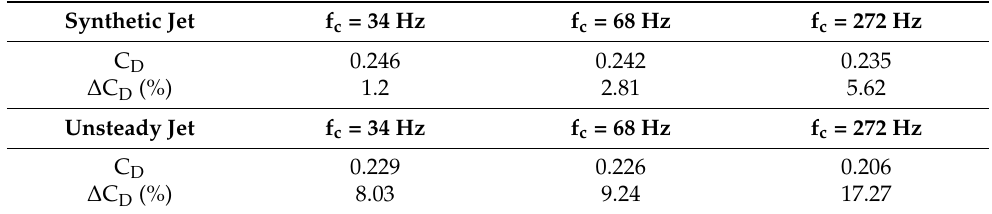
Table 3. Drag coefficient reduction with different actuator types at various control frequencies.